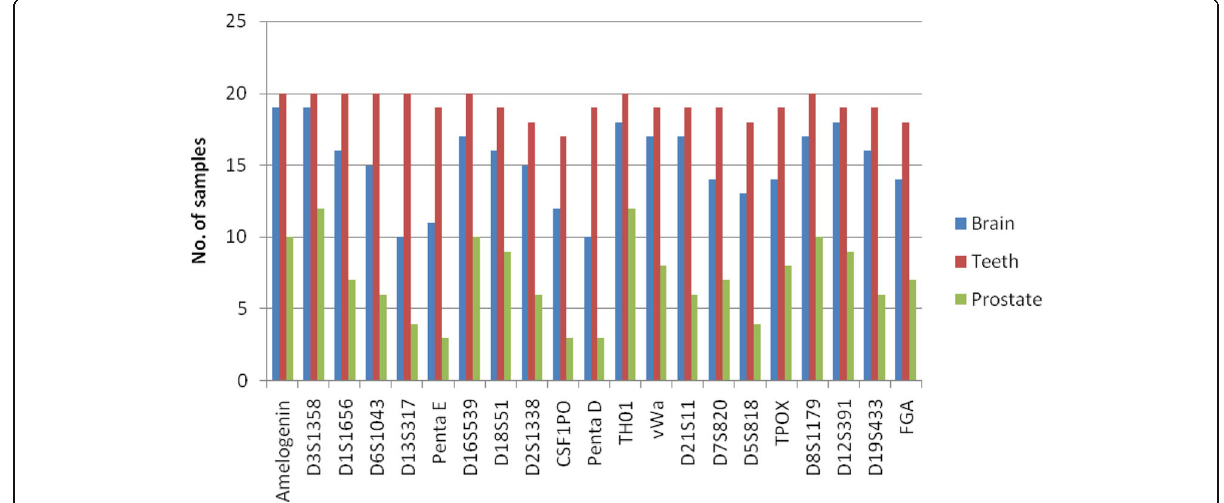
Fig. 4 Histogram showing distribution of each STR markers in different